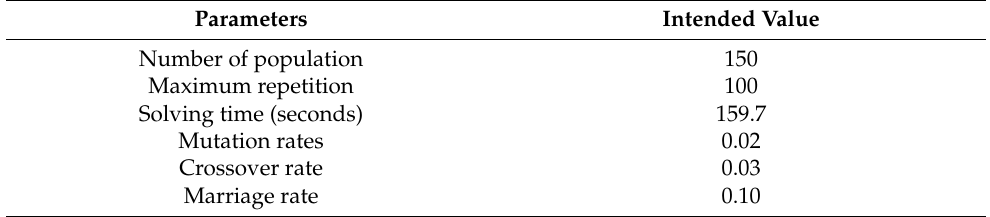
Figure 4. Number of initial population versus time of program implementation.